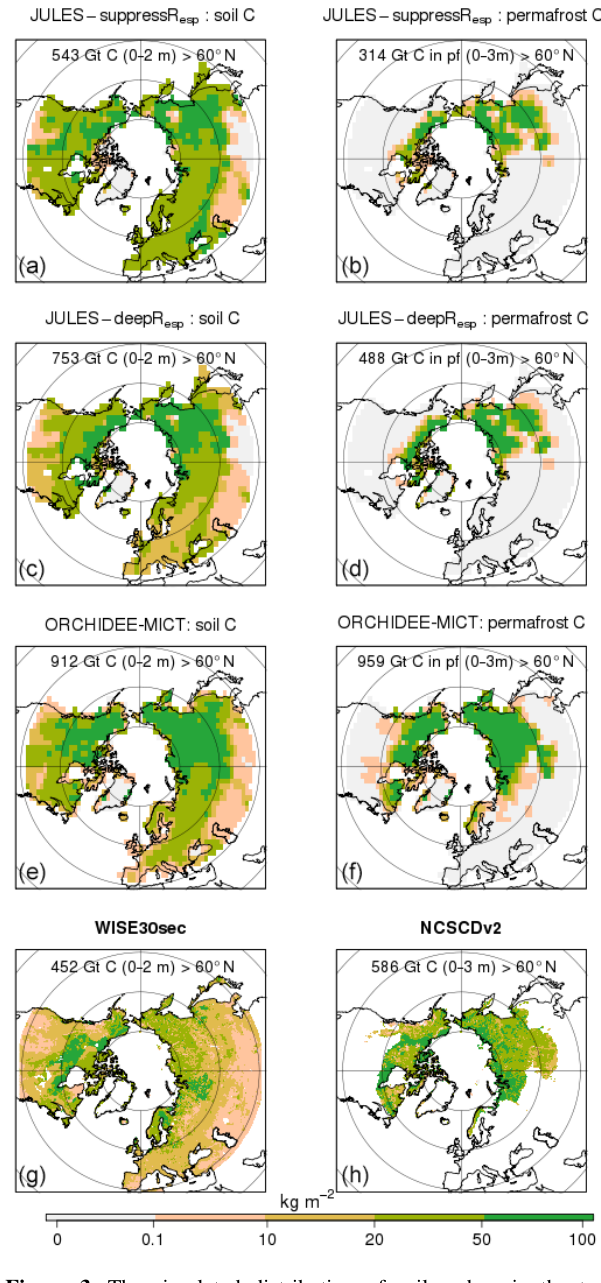
Figure 3. The simulated distribution of soil carbon in the top 2m (a, c, e, g) and the permafrost carbon in the top 3m (b, d, f, h) for the three different model versions (a–f) . (g, h) show the WISE30sec observed global data set for the top 2m (Batjes, 2016: g ) and the NCSCDv2 northern high-latitude total soil car- bon in the top 3m (Hugelius et al., 2014: h ). (b, d, f, h) The model simulations show just simulated permafrost carbon, whilst the NC- SCDv2 observations show total soil carbon.